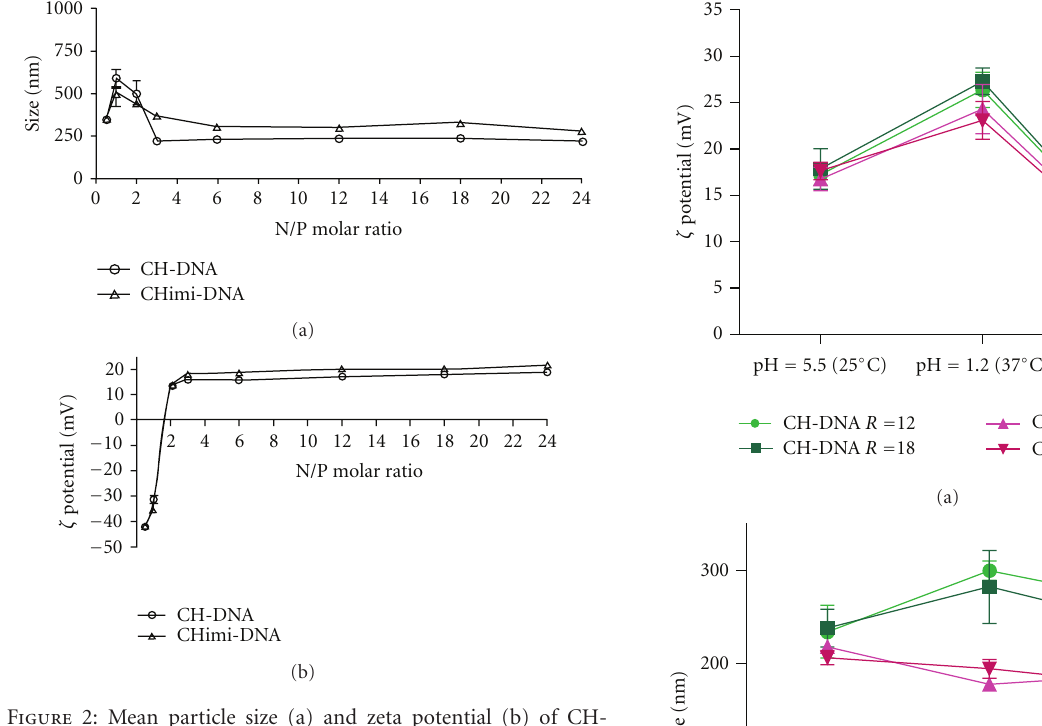
Figure 2: Mean particle size (a) and zeta potential (b) of CH- based complexes as a function of N/P molar ratio (measurements performed at 25 ◦ C, pH 5.5; average ± SD, n = 3).